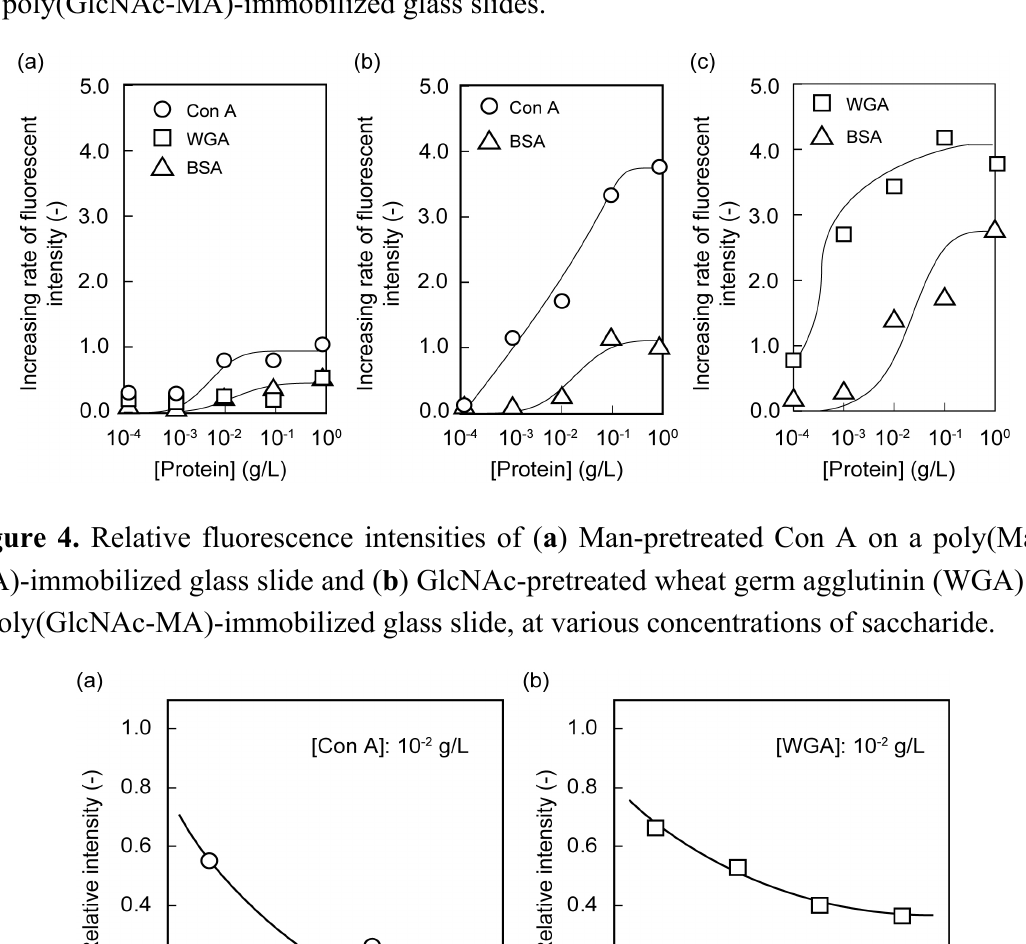
Figure 3. Increasing rate of fluorescence intensity for fluorescein isothiocyanate-labeled (FITC)-protein on ( a ) polyMA-immobilized; ( b ) poly(Man-MA)-immobilized; and ( c ) poly(GlcNAc-MA)-immobilized glass slides.